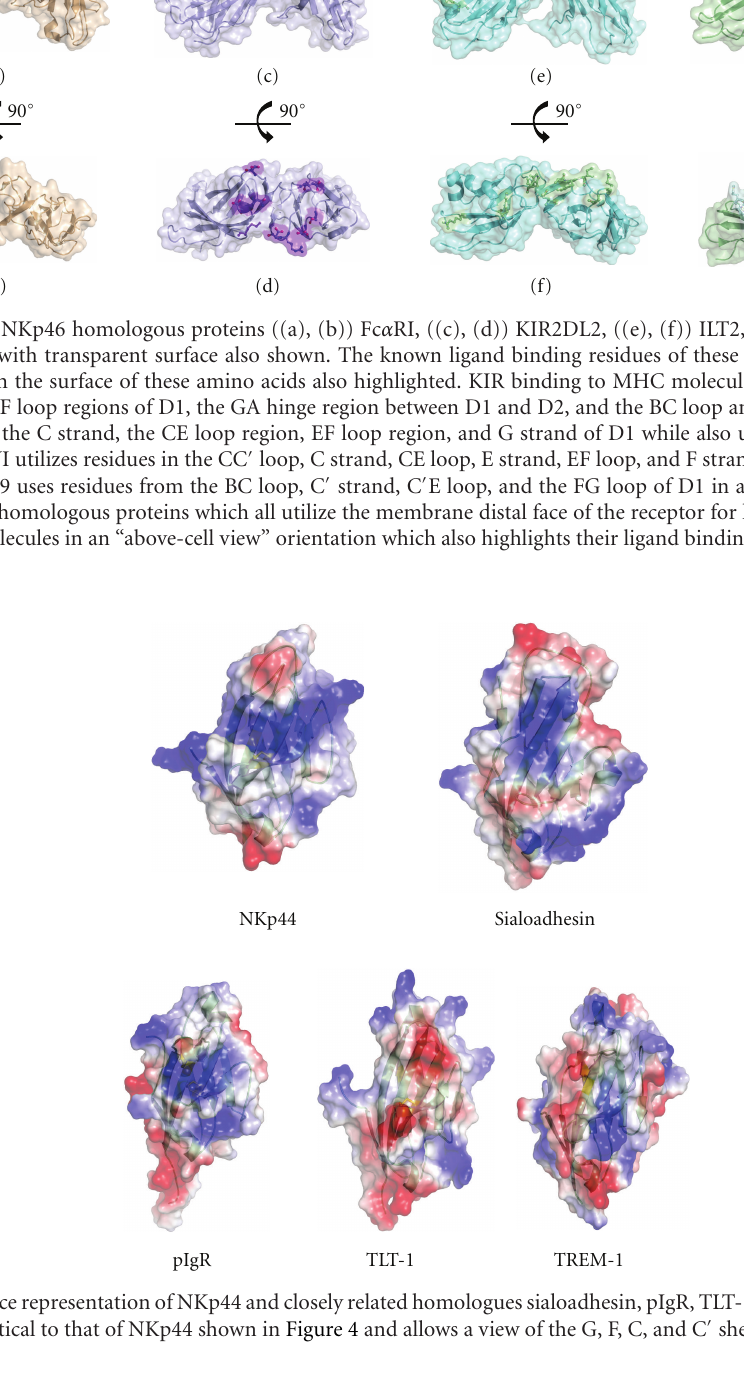
This groove is also positively charged and has been proposed as a ligand binding site. The NKp44 structure is homologous to a number of other Ig-like structures including TREM-1 (triggering receptor expressed on myeloid cells; rmsd: 2.0 ˚ A) [53, 54], TREM-like transcript-1 (rmsd: 1.7 ˚ A) [55], poly Ig receptor (rmsd: 2.1 ˚A) [56], sialoadhesin (rmsd: 2.4 ˚A) [57],